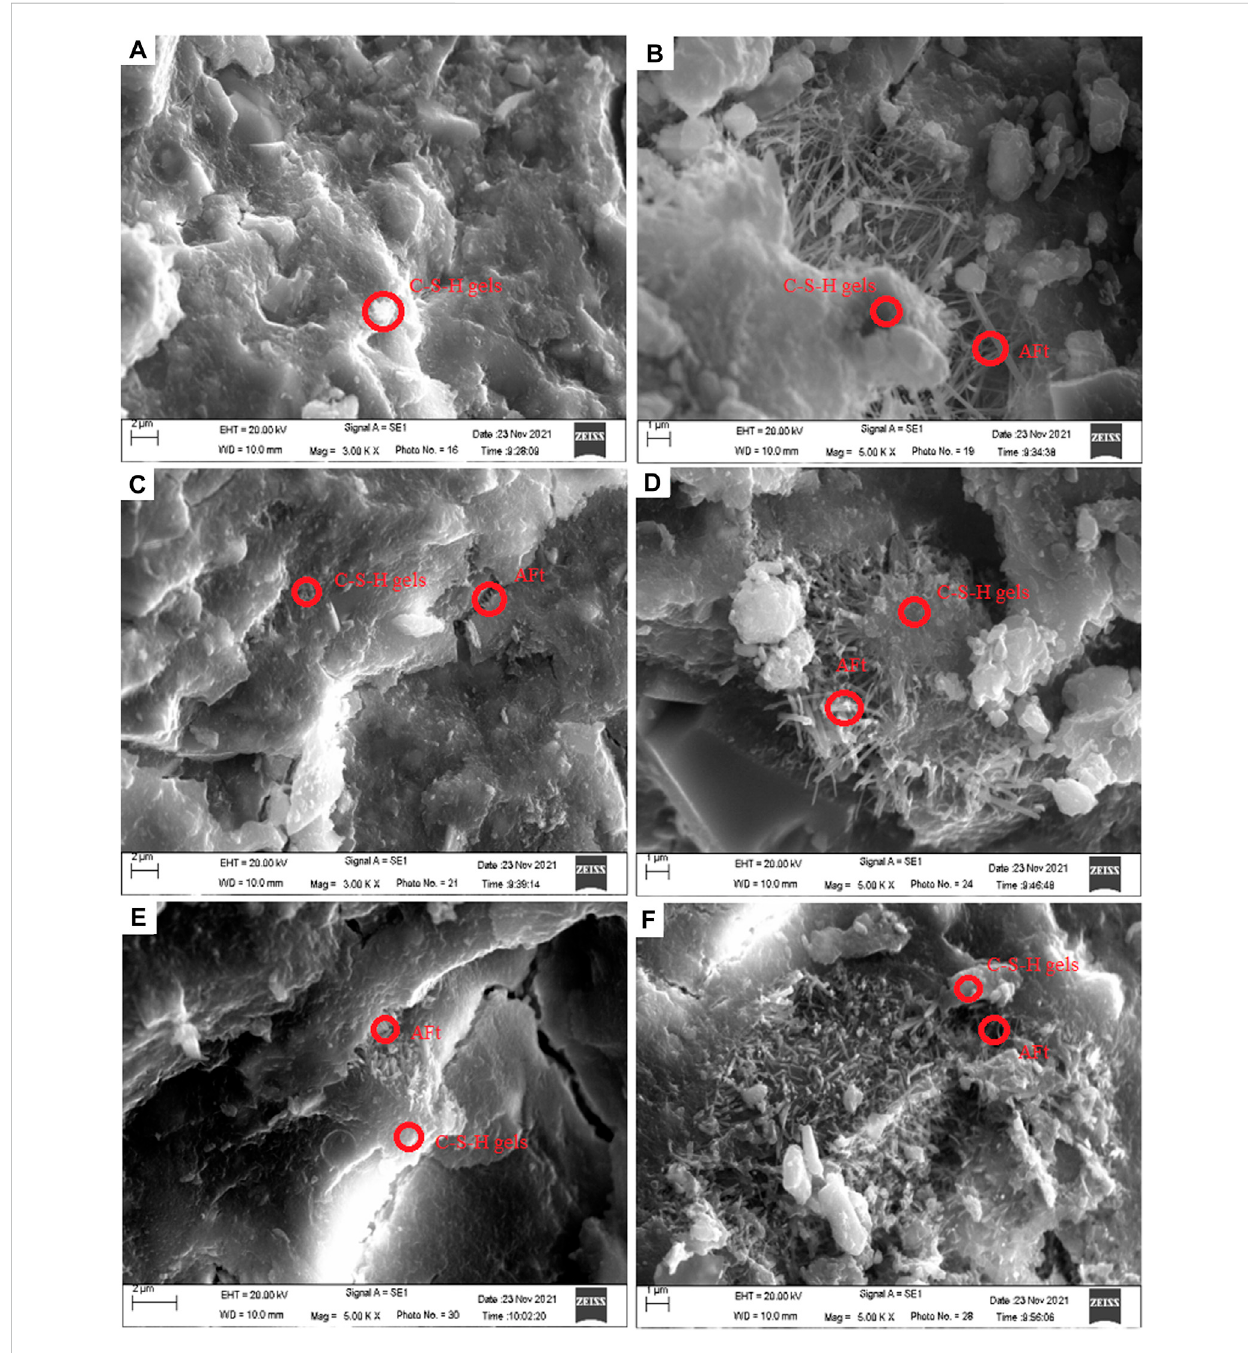
FIGURE 10 SEM images of CA paste samples at different ages. (A) and (B) 3 d; (C) and (D) 7 d; (E) and (F) 28 d.